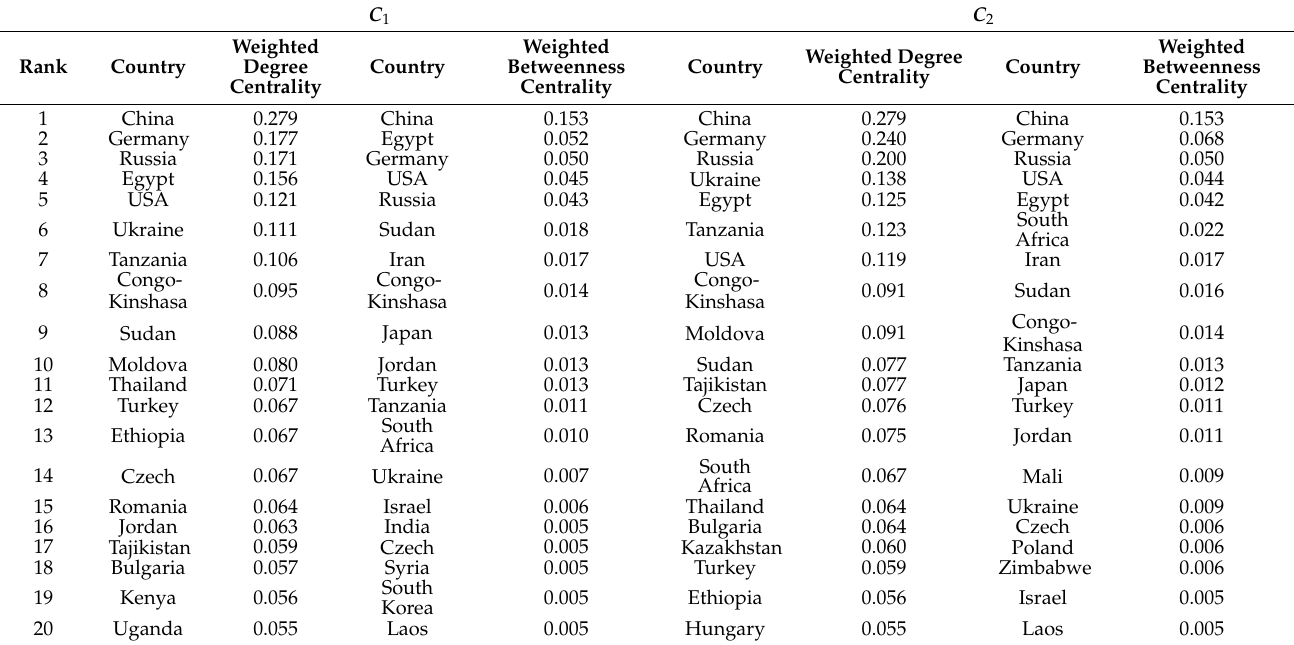
Table 3. Countries’ hierarchies based on weighted centrality indicators. C 1 C 2